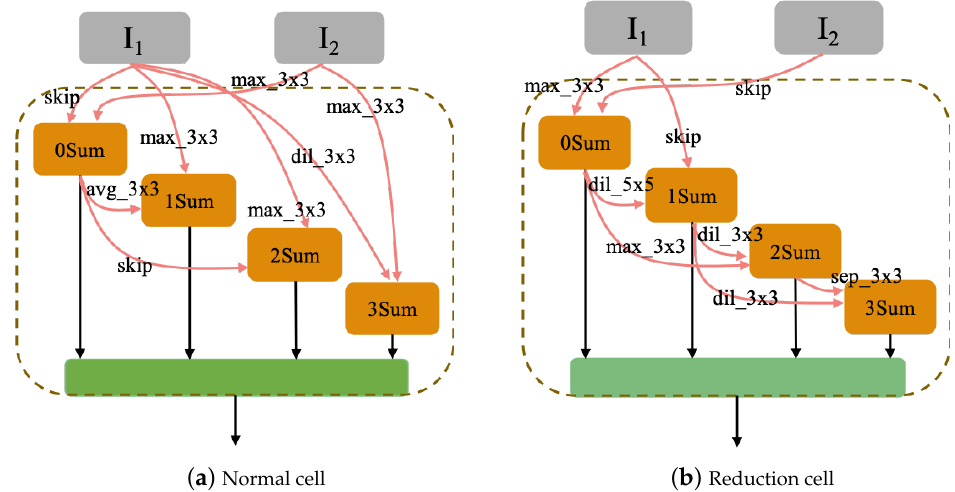
Figure 10. Optimal architecture of PSO-Net for the biased Pavia dataset.